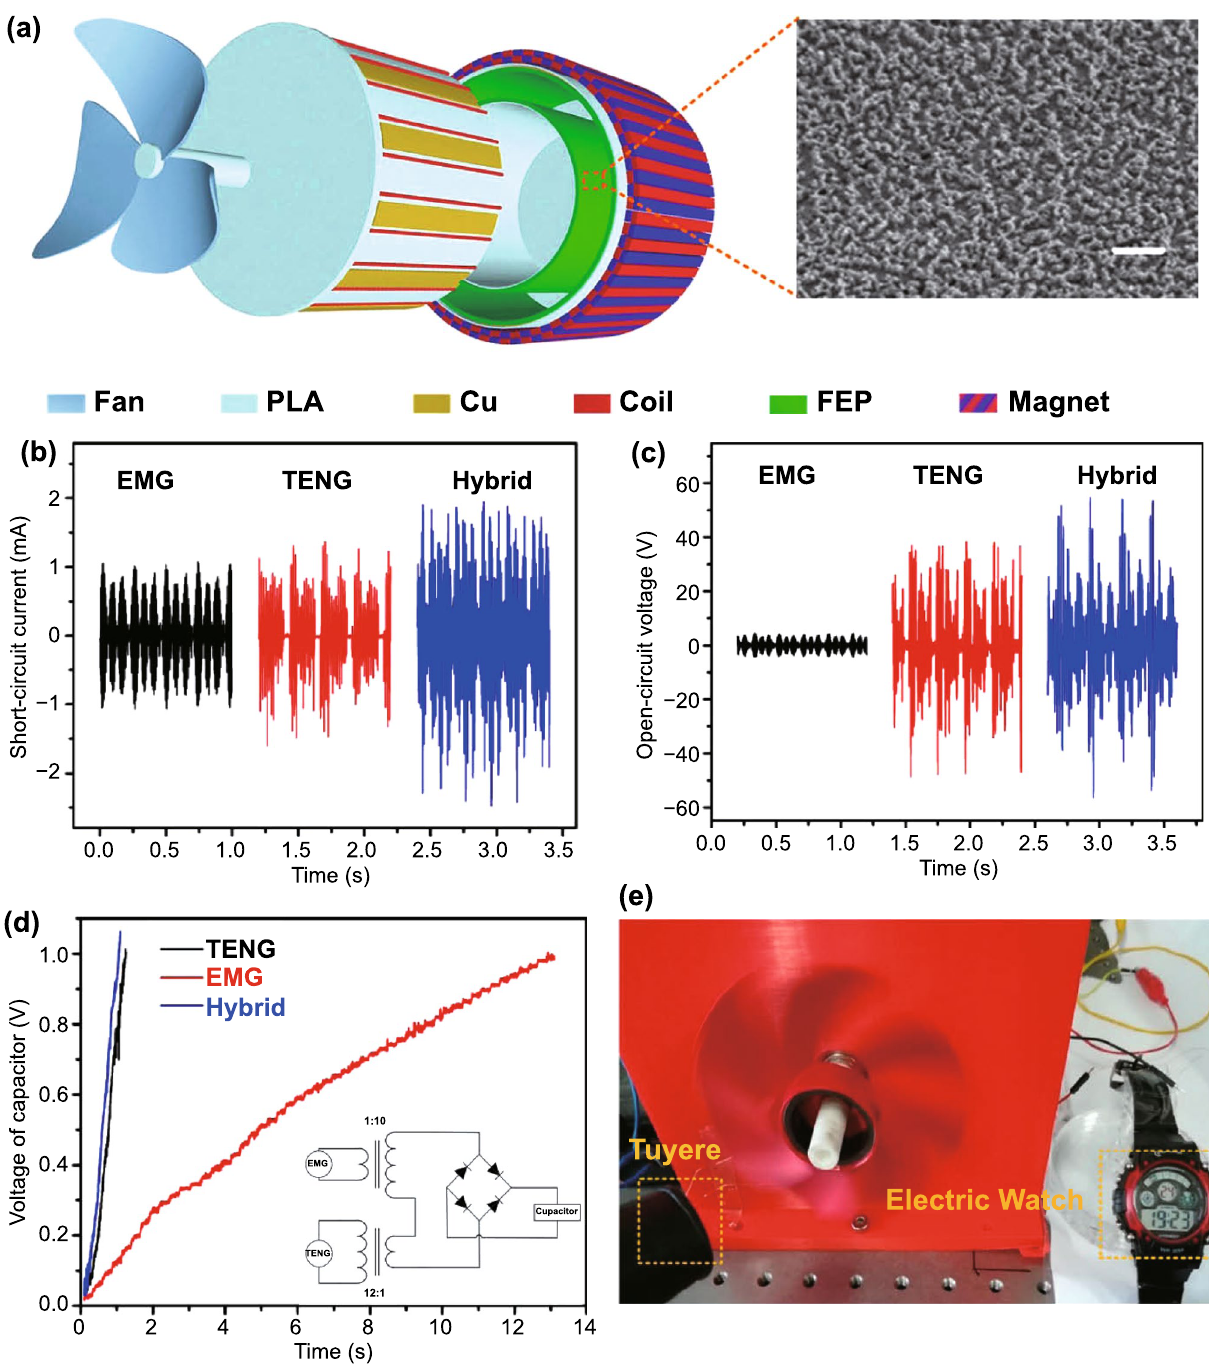
Fig. 11 a Structure of the rotating-sleeve hybrid E-TENG generator nanogenerator and SEM image of the FEP film nanostructure (scale bar, 2 μm) engineered by Cao et al. b SC current of the EMG, TENG and hybrid with transformers when connected in parallel. c OC voltage of the EMG, TENG and hybrid with transformers when connected in series. d Charging curves of a 470 μF capacitor by the TENG, EMG and hybrid and equivalent rectifier circuit diagram. e Demonstration of an electronic watch powered by the hybrid generator under blowing wind from a tuyere. Reproduced with permission from Ref. [67]. Copyright 2017, American Chemical Society. (Color figure